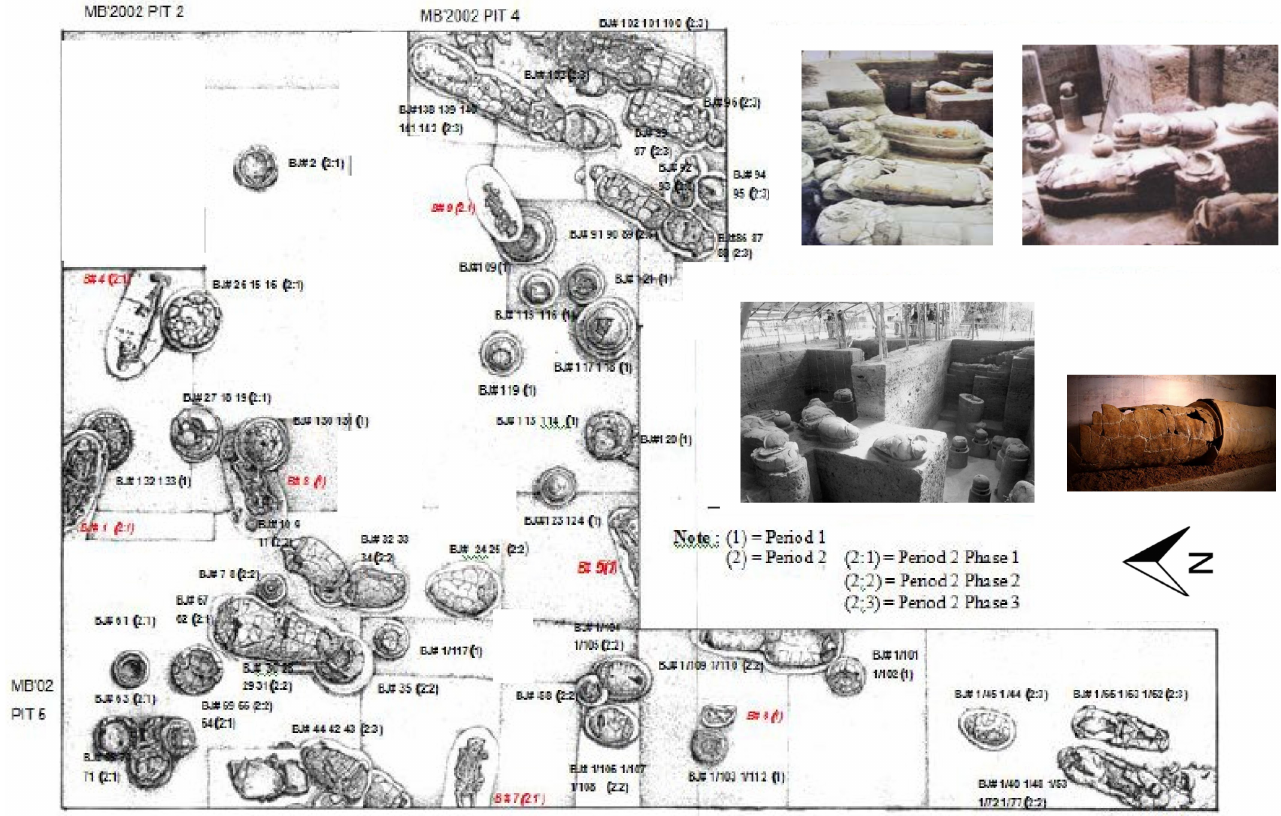
Figure 2. Plan of jar burial sample pits at Ban Muang Bua. Adapted with permission from ref. [24] (2010) (Fine Arts Department: Ubol Ratchathani,